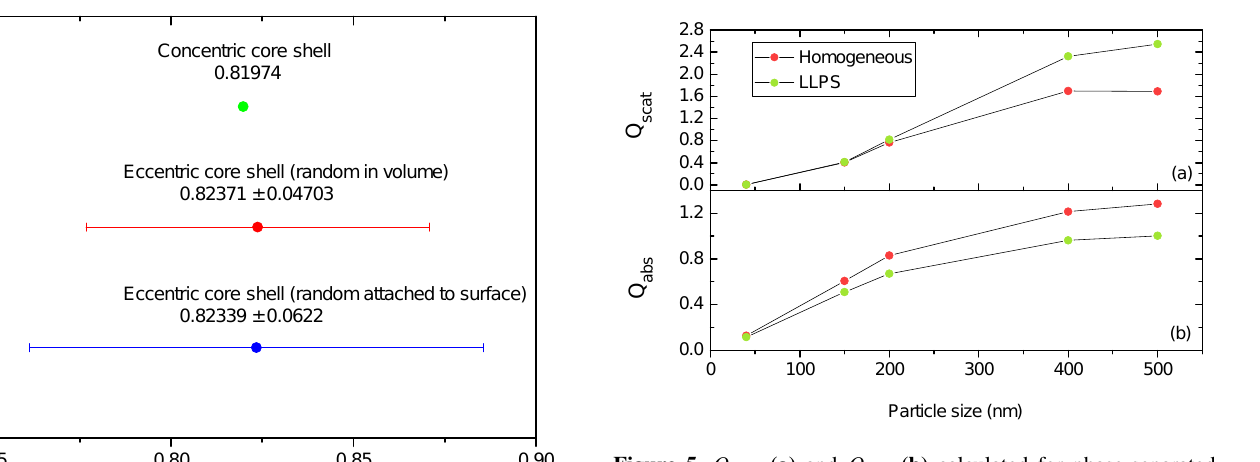
Figure 5. Q scat (a) and Q abs (b) calculated for phase-separated (LLPS) and homogeneous particles ranging from 40 to 500nm at OIR = 1 : 4 and k = 0 . 168 using the eccentric core-shell Mie code at λ = 355nm. The red and green dots show the results for the same system at specific particle size for homogenous and phase-separated (LLPS) particles, respectively. The lines are only meant to guide the